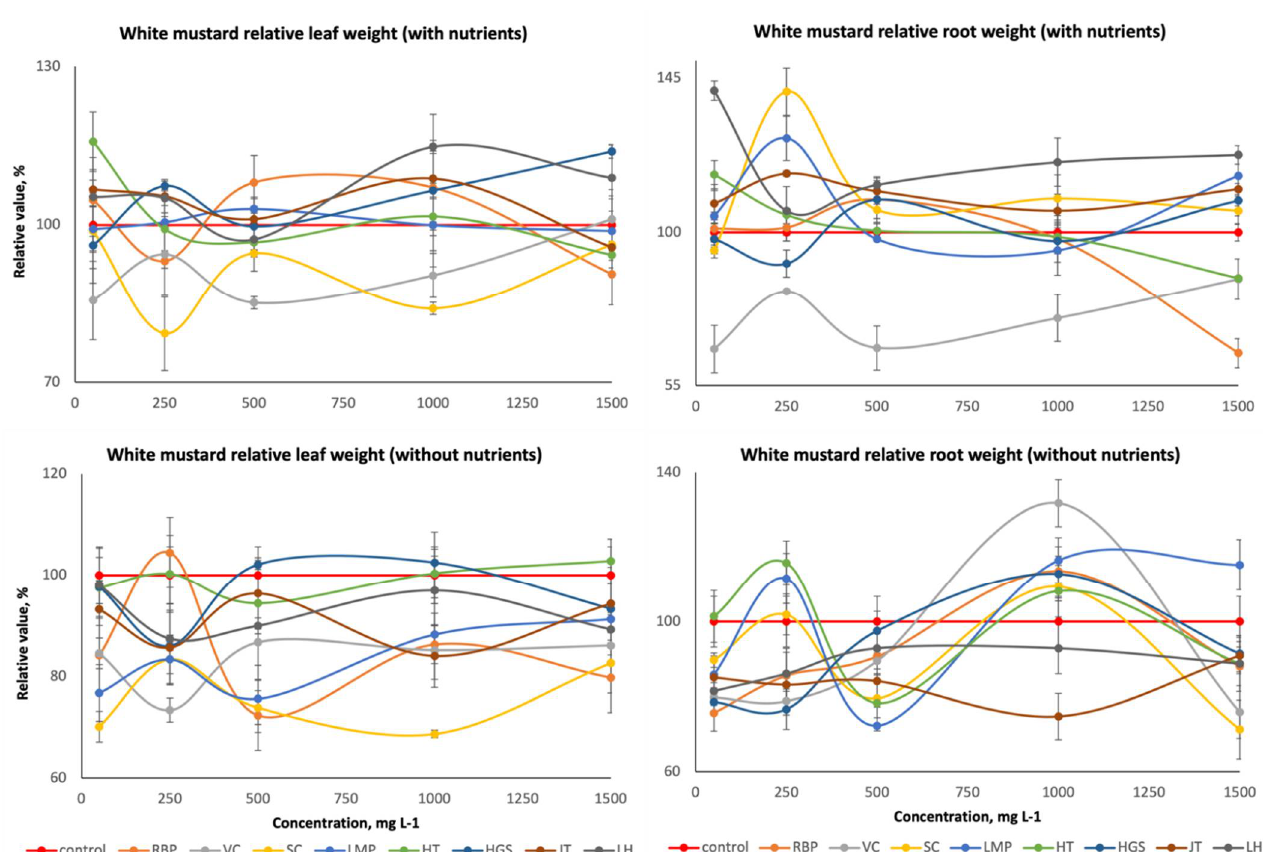
Figure 2. Relative changes in white mustard ( Sinapis alba ) shoot and root weight over a concentration range of potassium humate solutions of different origins, with and without added nutrient solution. RBP = raised bog peat, VC = vermicompost, SC = soil compost, LMP = low moor peat, HT = Humin Tech potassium humate, HGS = Humic Growth Solutions potassium humate, JT = Jin Tai FA, LH = Lignohumate HS.